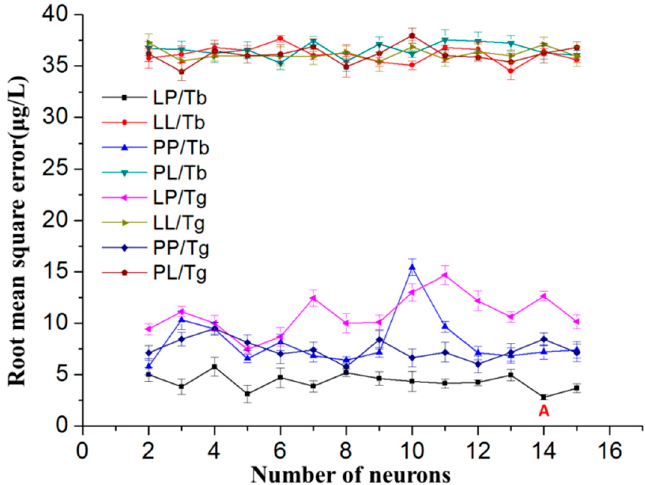
Figure 6. Selection and optimization of the ANN model. The transfer functions and training functions: Logsig and Pureline (LP), Logsig and Logsig (LL), Pureline and Pureline (PP), Pureline and Logsig (PL), Trainbr (Tb), and Traingdx (Tg).